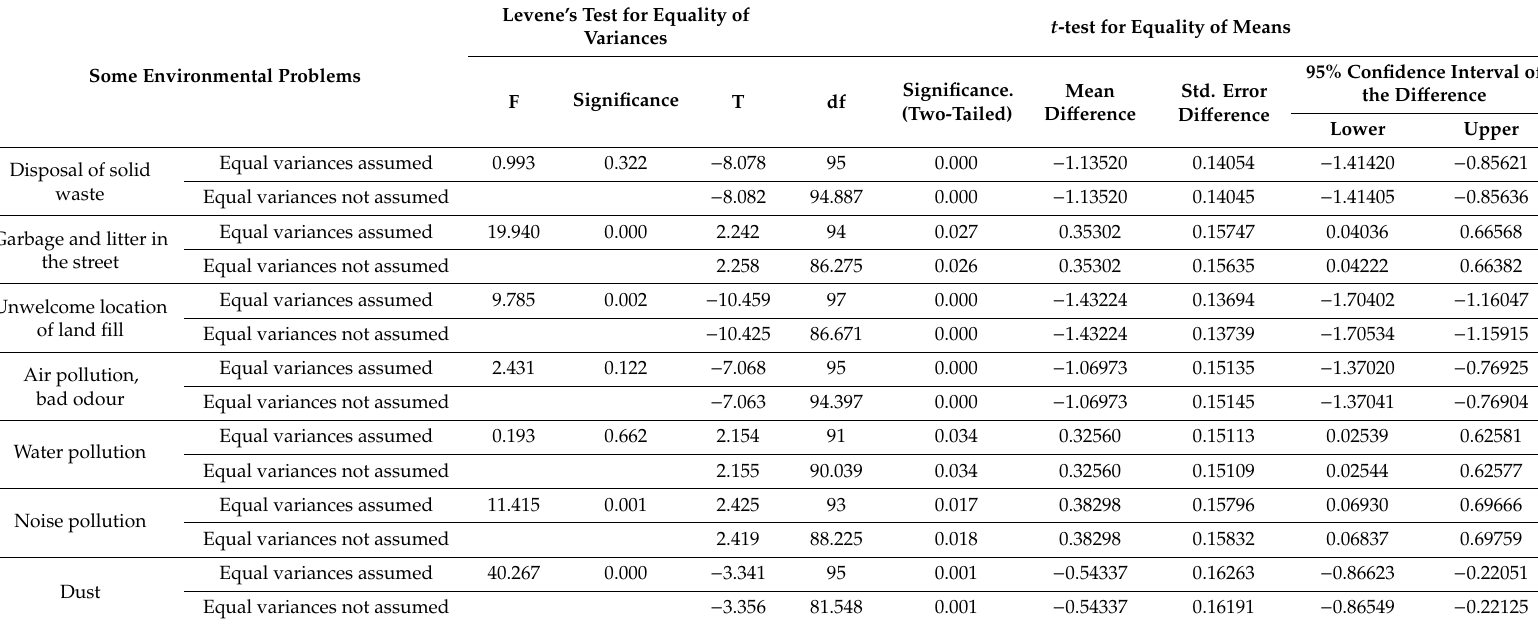
Table A1. Independent samples test of environmental problems in the